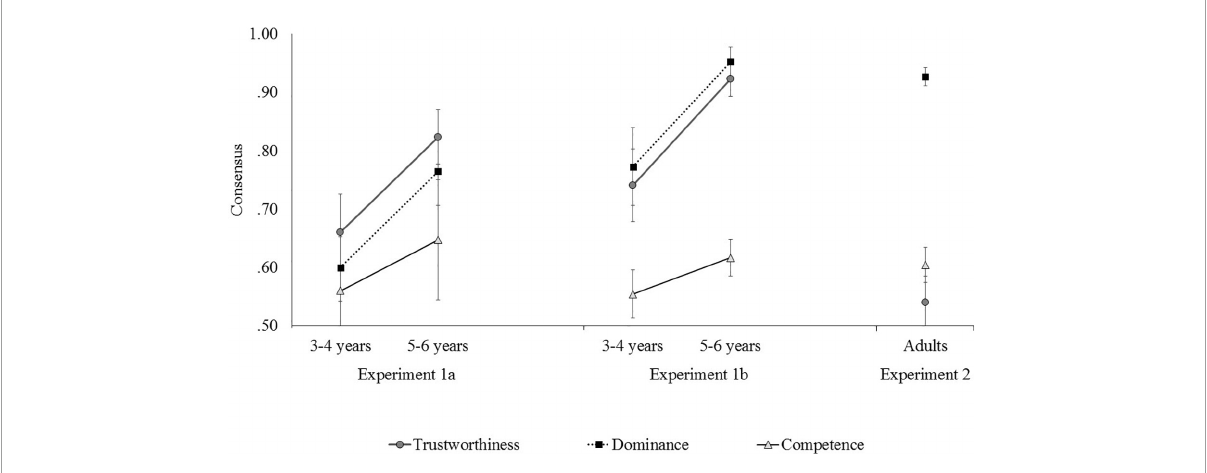
FIGURE1 Consensus data for Japanese young children (Experiments 1a and 1b) and adults (Experiment 2) with the U.S. adults are shown together. (The error bar indicates standard error).